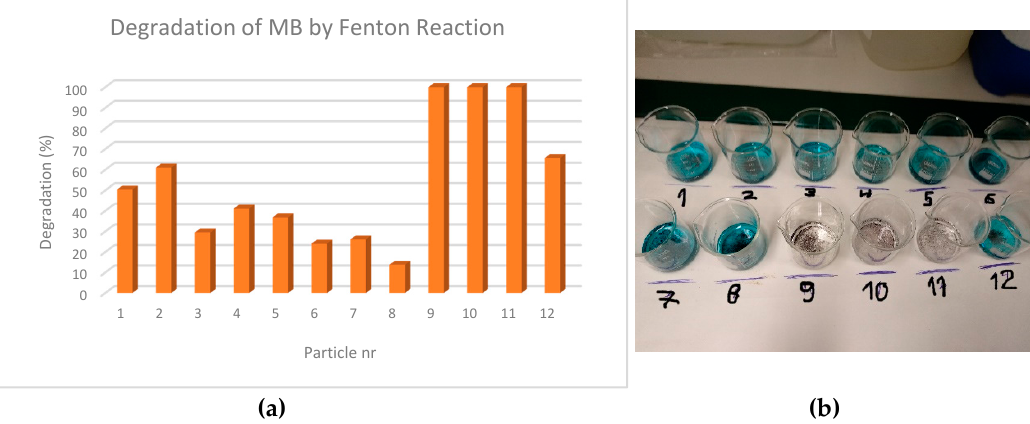
Figure 5. Degradation (%) of the colorant present in the water samples by Fenton reaction: ( a ) chart; ( b ) photograph of the final process results.